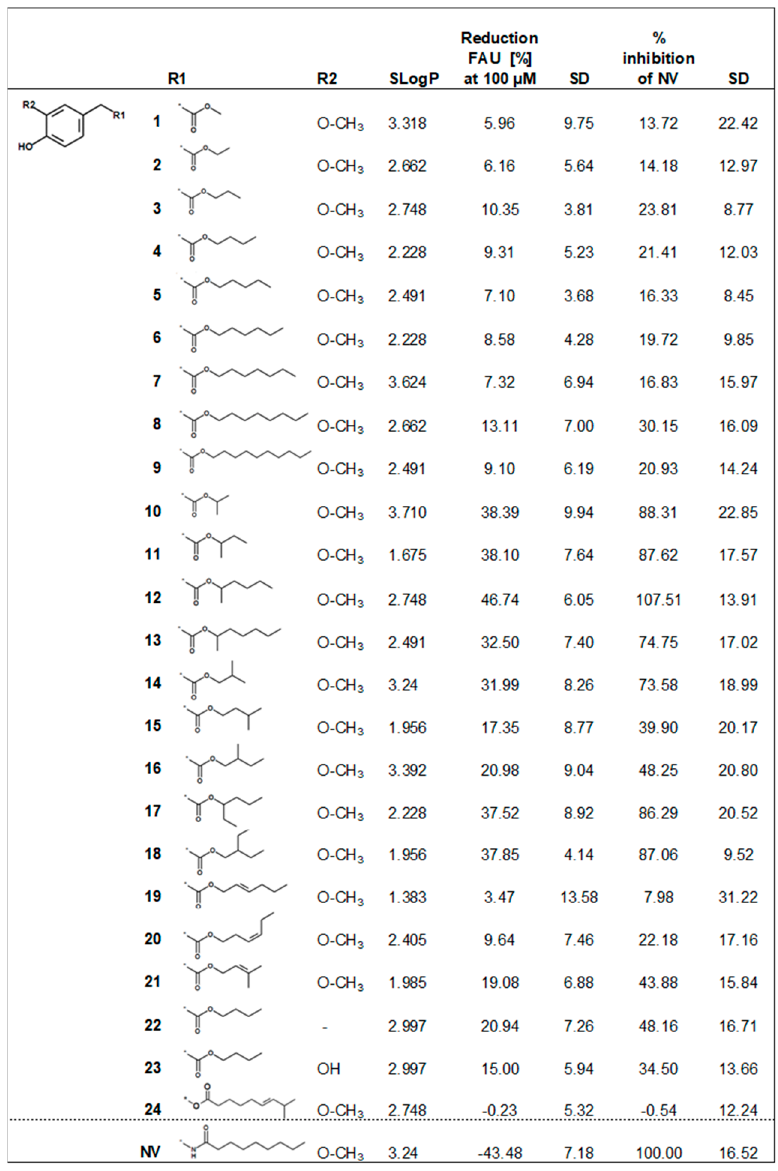
Figure 2. Overview of the tested naturally occurring and synthesized homovanillic acid esters, their SLogP values, and their potency to reduce fatty acid uptake (FAU) at 100 µ M in relation to non-treated control cells (0% inhibition) or as % of the positive control nonivamide (NV, − 43% inhibition of control level). Displayed is the mean of three independent experiments with two technical replicates per measurement for each